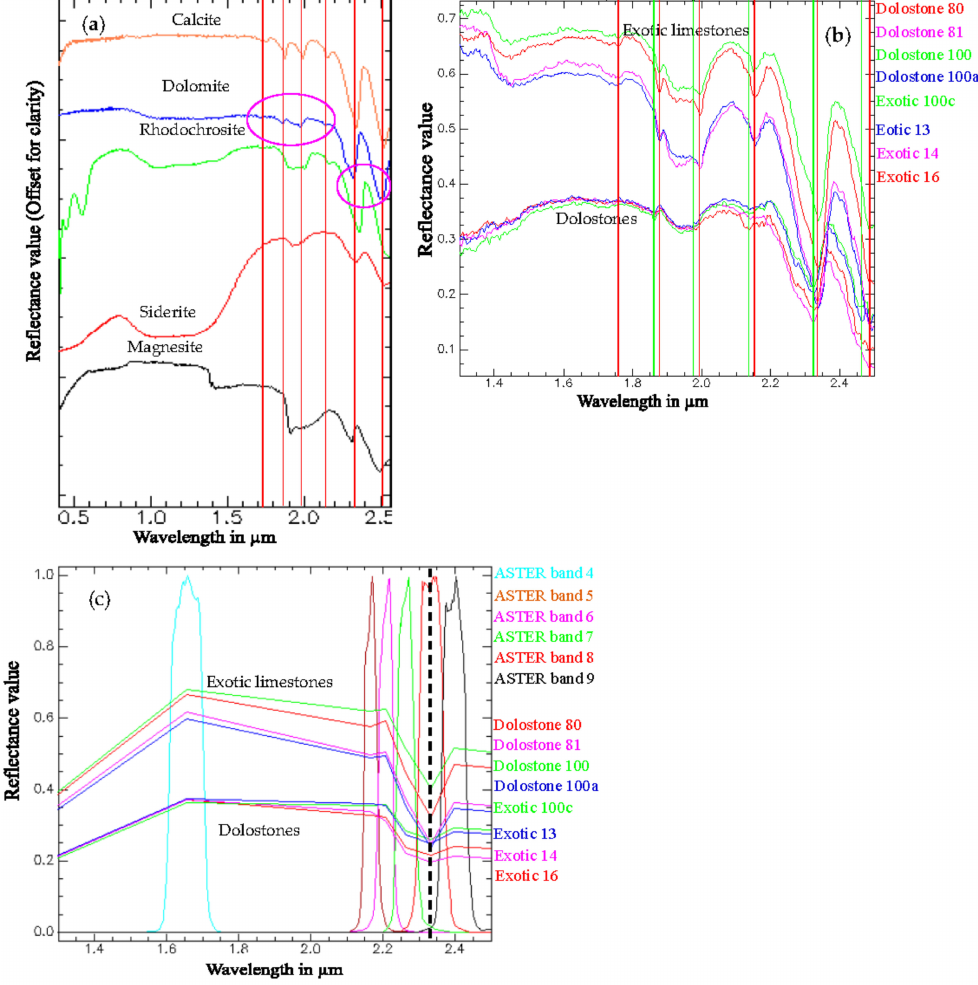
Figure 2. Spectral plots. ( a ) Spectra of carbonate minerals stacked from the USGS Spectral Library for minerals in 0.3 to 2.5 µ m (red vertical lines—calcite absorptions, pink ellipses—dolomite absorptions); ( b ) Spectra of exotic limestone and dolostone rocks measured in 1.3 to 2.5 µ m (red vertical lines—exotic limestone absorptions, green vertical lines—dolostones absorptions); ( c ) Spectra of exotic limestone and dolostone rocks resampled to SWIR spectral bands of ASTER in 1.3 to 2.5 µ m (black dashed line—carbonate absorption in ASTER band